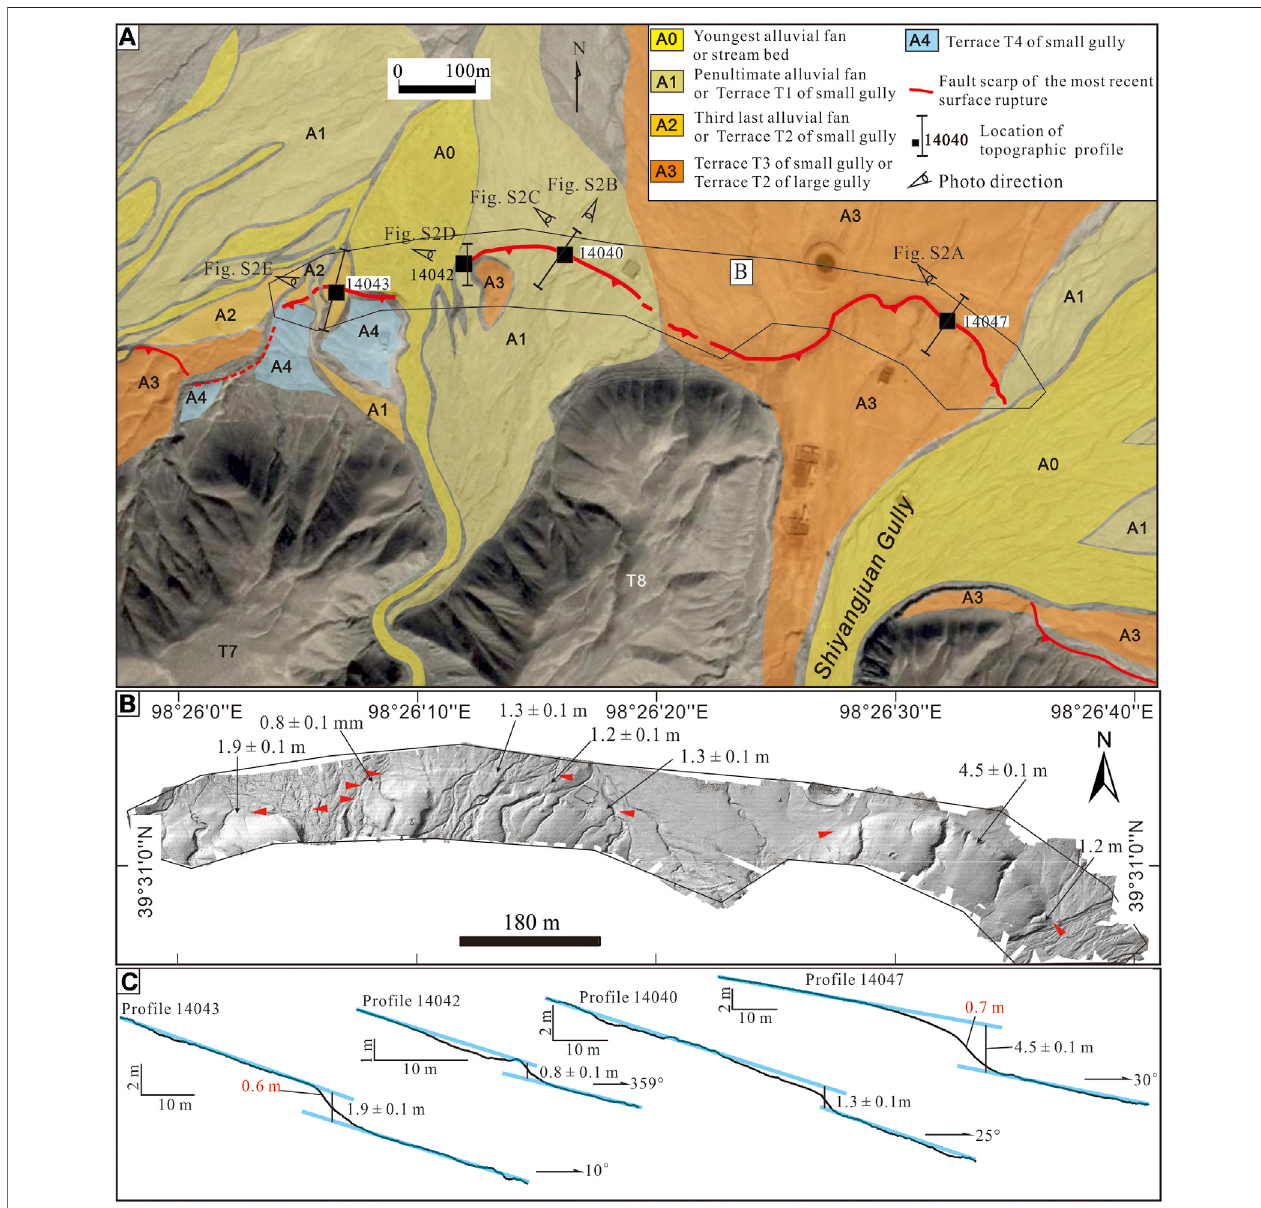
FIGURE 5 | Topographic features of the 1609 earthquake surface rupture at the Shiyangjuan site. (A) Surface rupture map (B) Hillshade DEM extracted from UAV aerial photography along the Shiyangjuan segment. (C) Topographic pro fi les across portions of 1609 rupture traces.